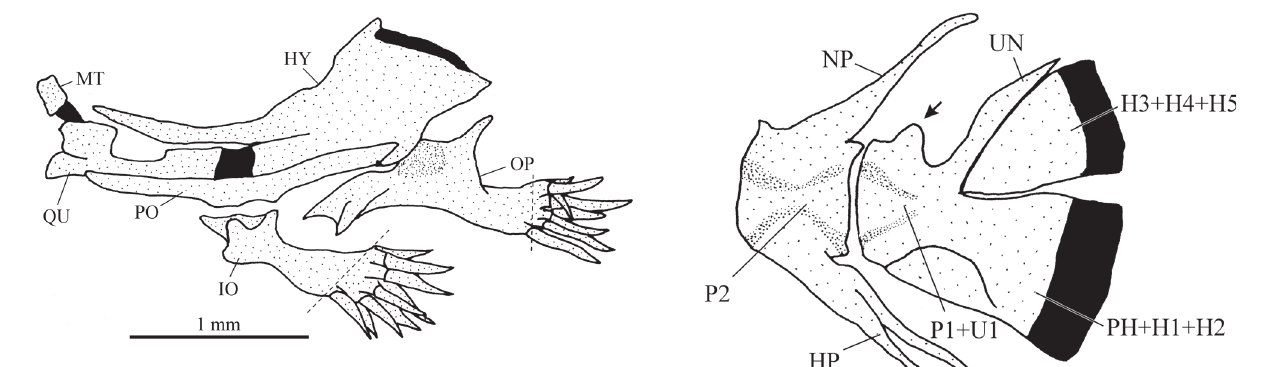
canal with one pore, corresponding to pterotic branch, at vertical just posterior to opercular patch of odontodes. Main lateral line short, with two pores: anteriormost largest, at vertical just posterior to pectoral-fin base; posteriormost below and just posterior to first pore.